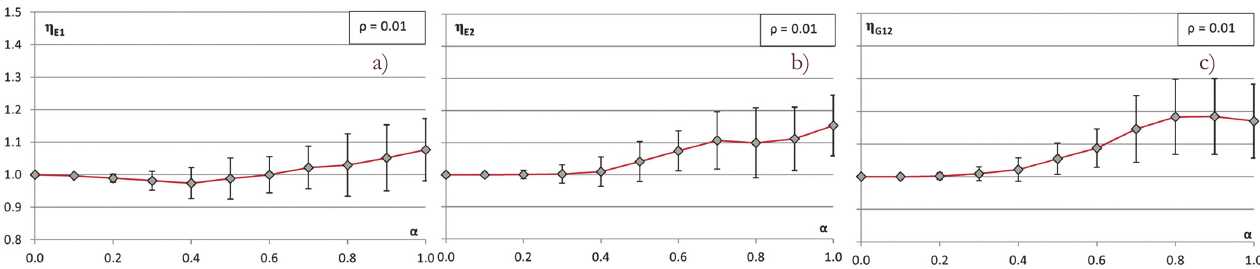
Figure 17: Correction factors vs. irregularity parameter for ρ =0.01: a)  E1,A ; b)  E2,A ; c)  G12,A .